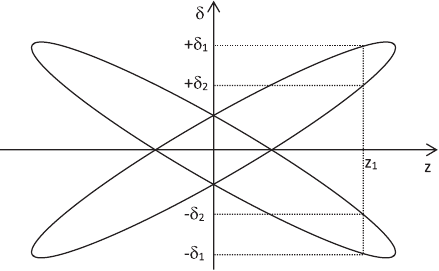
FIG. 7. Colliding beam ellipses in longitudinal plain, showing correlation between collision energy deviation δ and longitudinal position z